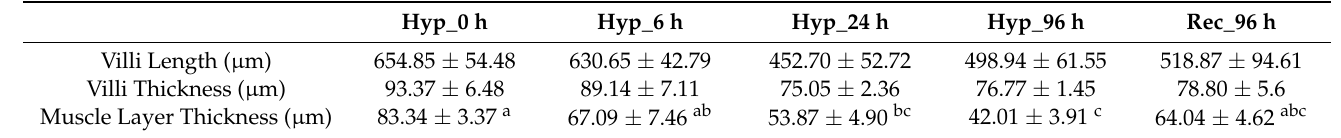
a , b , c Within each row, different letters indicate significant differences among groups.